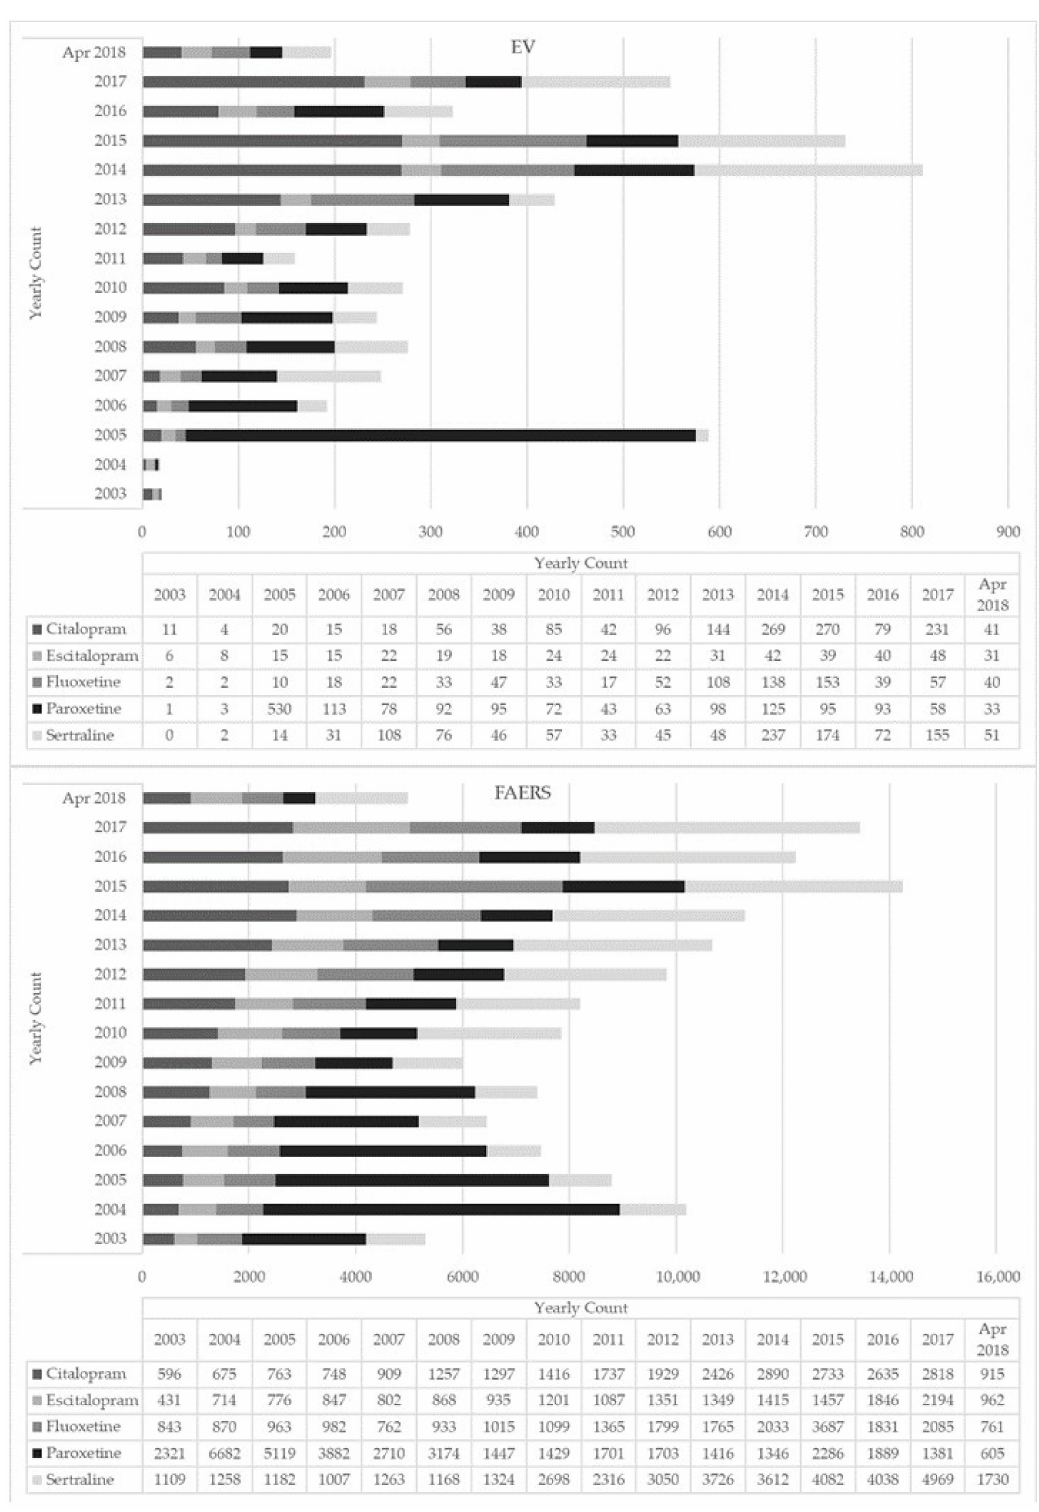
Figure 1. Yearly count of selective serotonin reuptake inhibitor (SSRI)-related adverse drug reactions reported to EudraVigilance (EV) and the Food and Drug Administration (FDA) Adverse Event Reporting System (FAERS) (2003–April